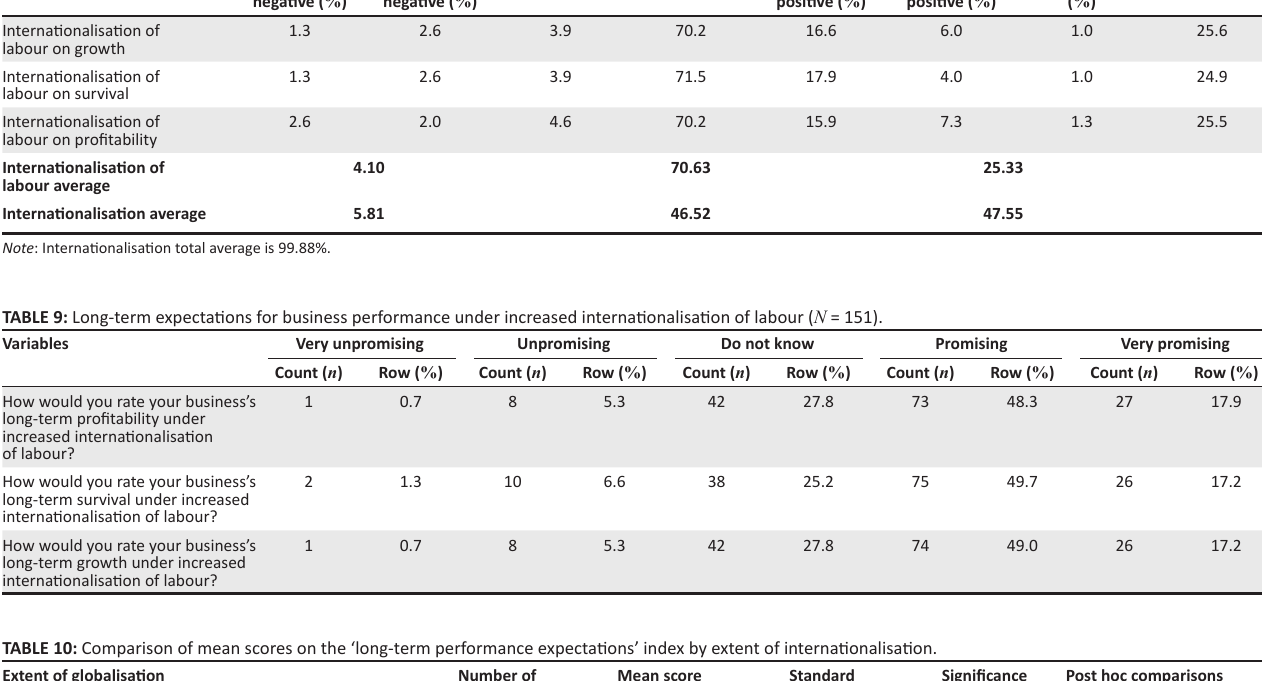
TABLE 8: Perceived influence of internationalisation of labour on the performance of small-scale agricultural businesses. Aspects of internationalisation